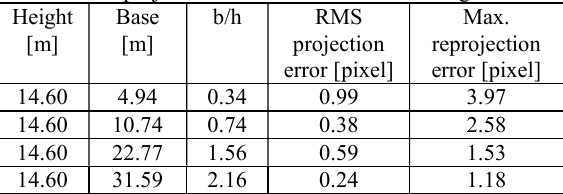
Fig. 5. The images that have different base length ratio Table 4. Reprojection error for different base/height